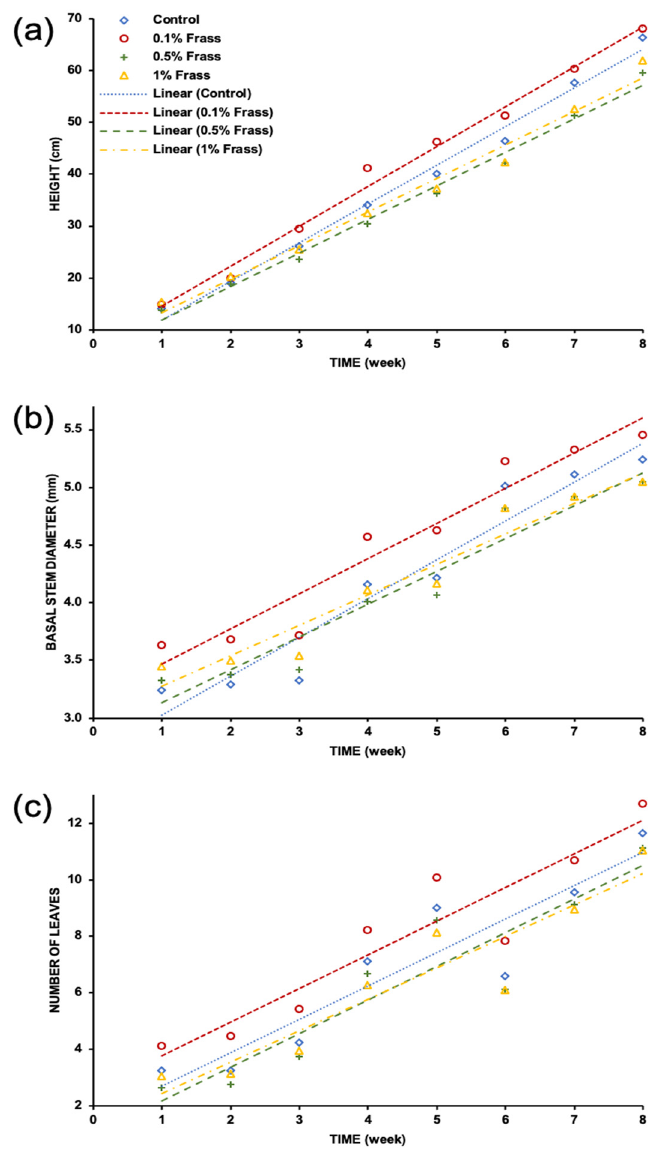
Figure 1. Dispersion diagram of morphological variables ( a ) height, ( b ) basal stem diameter, and ( c ) the number of leaves.